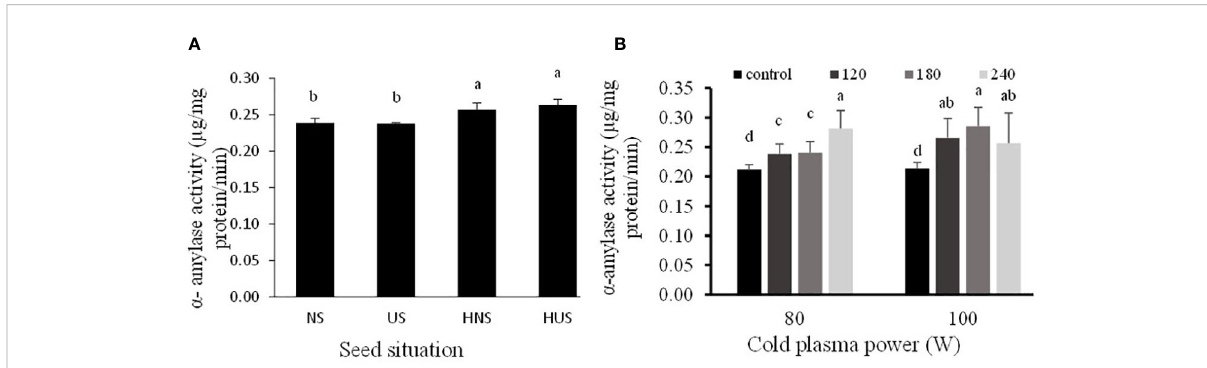
FIGURE 7 The individual effect of seed situation (A) and power of cold plasma (B) on a -amylase activity of S. leriifolia germinated seeds. Values represent mean ± S.E. Different letters indicate signi fi cant differences at the I and 5% level for seed situation and power of cold plasma according to the LSD test, respectively.